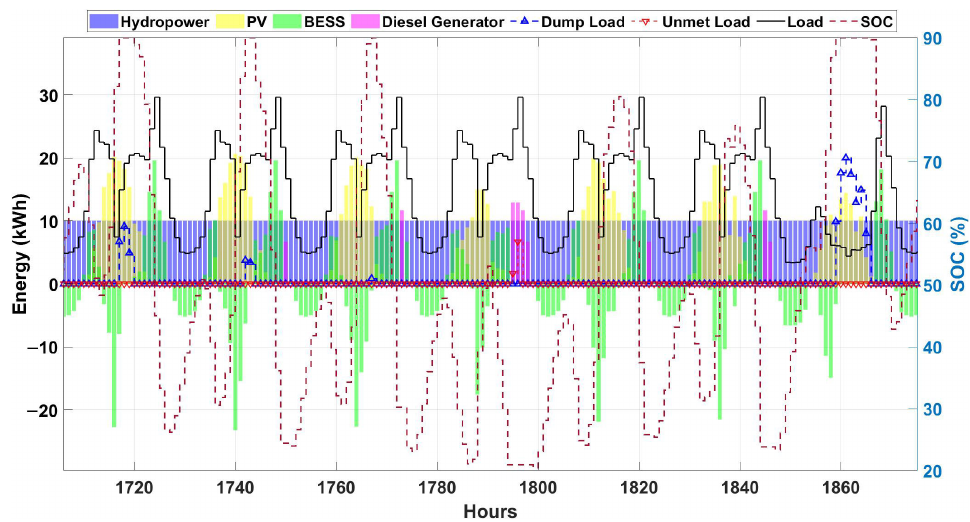
Figure 21. Energy scheduling—Scenario 3—with agricultural load and low solar radiation.